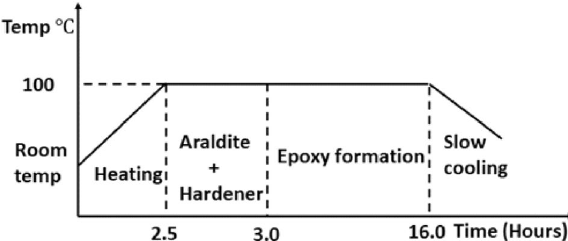
Figure 3. Epoxy resin casting cycle.